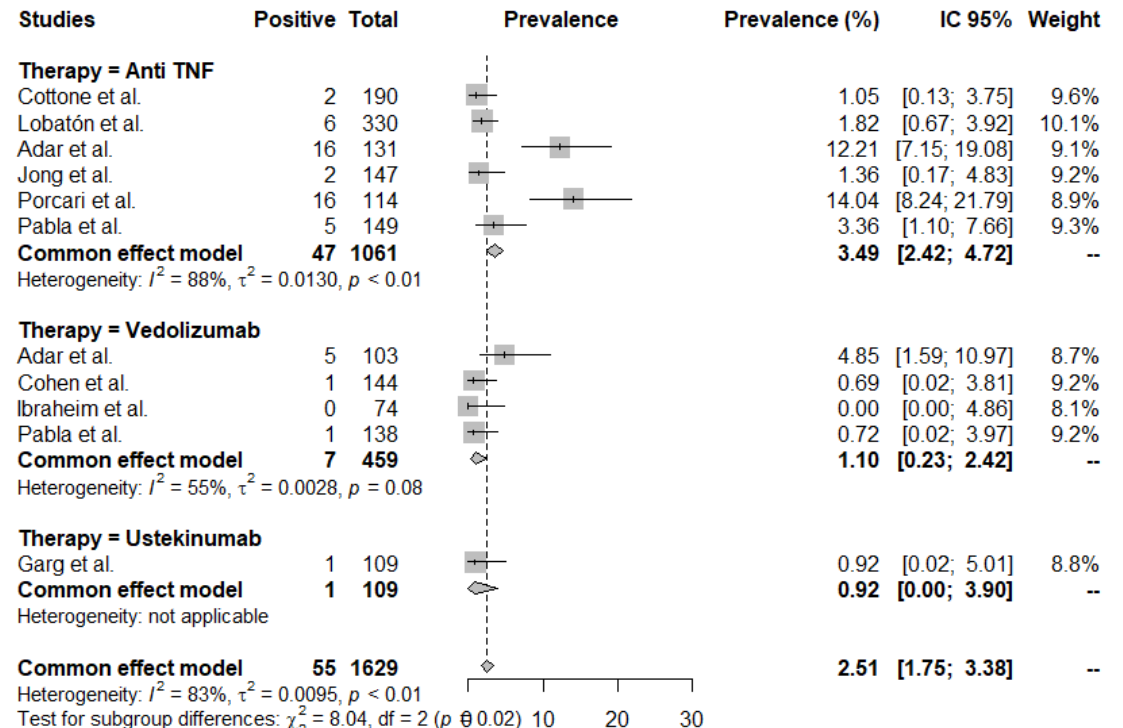
Figure 3. Rates of infection. Mean rates per 100 patient years (PY).